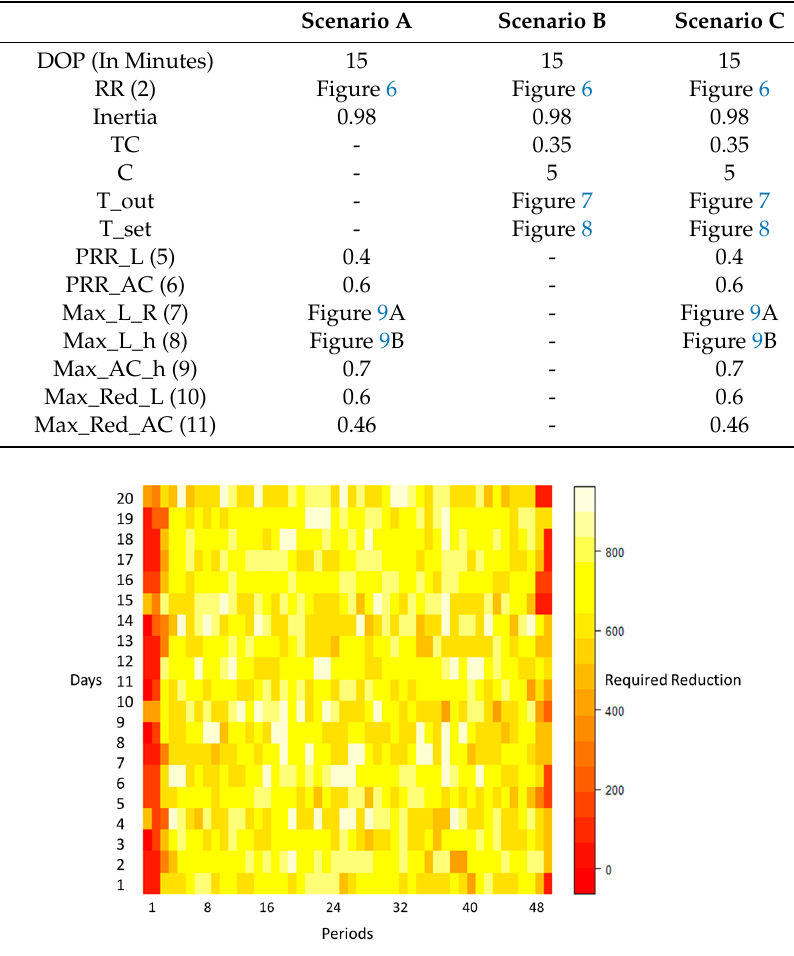
Figure 6. The demand for power reduction in each period for 20 days.